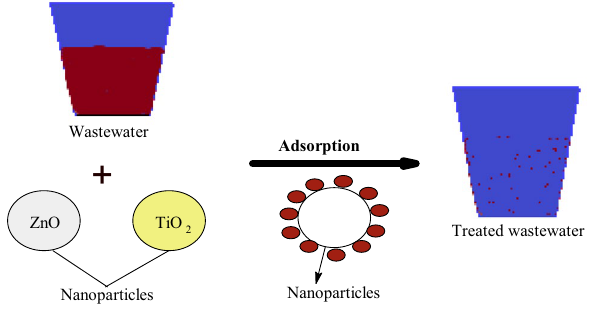
Fig. 15 Adsorption process using